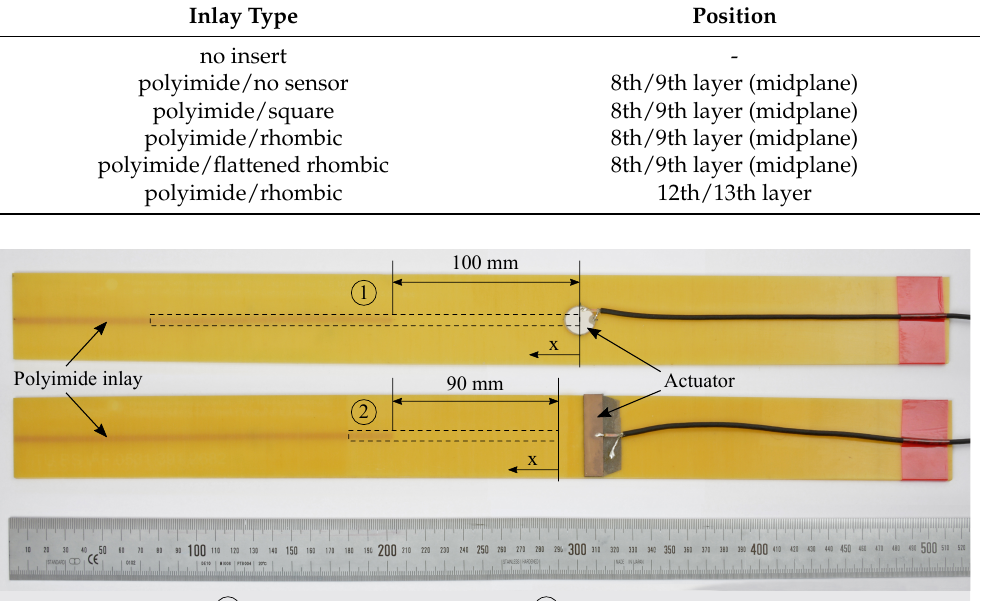
Table 1. Overview of the strip specimen configurations.